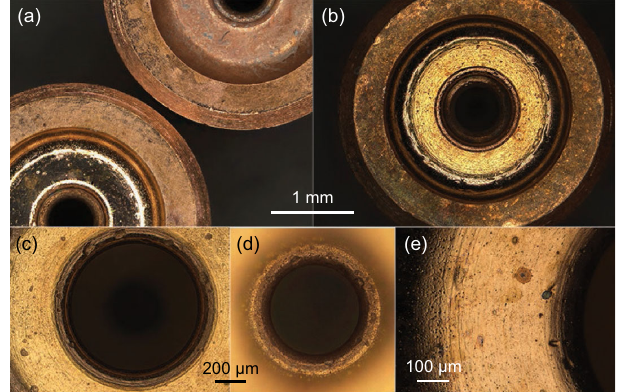
FIG. 8. Microscope images of different gun structures. All of the images are stacked focus images. (a) Side-by-side comparison of two structures showing the different surface finishes. (b) Image of a structure showing both irises and the input coupling section. The surface finish on the outer surface which mates with the input waveguide shows more wear and tear than the cell surfaces. (c) Close-up view of the coupling iris. There are pits visible in the iris. These features will likely be smoothed during high power processing. (d) The inner iris, viewed with the same magnifica- tion as (c). (e) Close-up view of the coupling iris edge and surface of the coupling